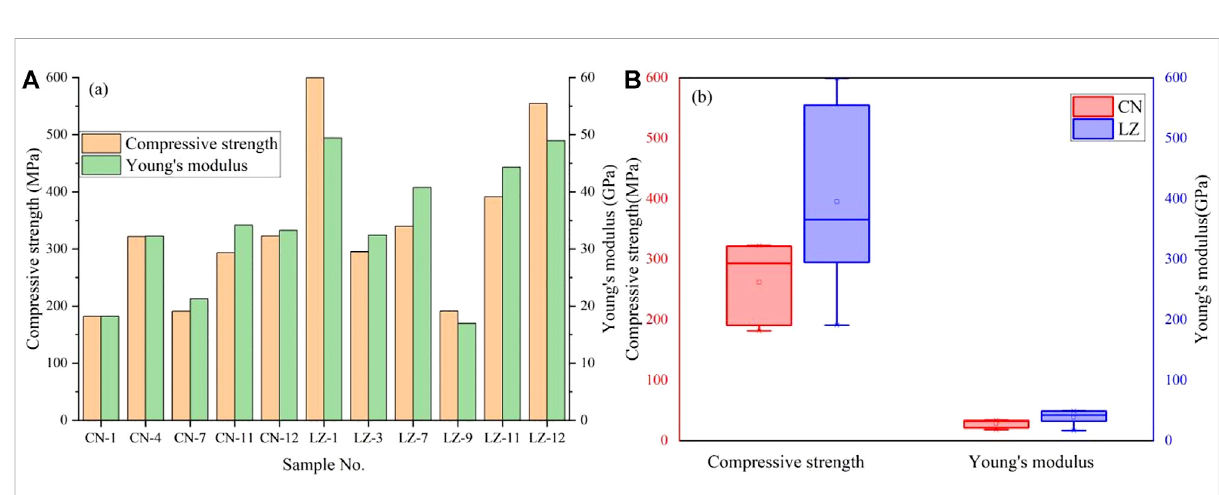
FIGURE 7 Distribution of compressive strength and Young ’ s modulus of the Longmaxi Formation shale in the study area. Notes: (A) Test results of compressive strength of different samples; (B) Distribution intervals of compressive